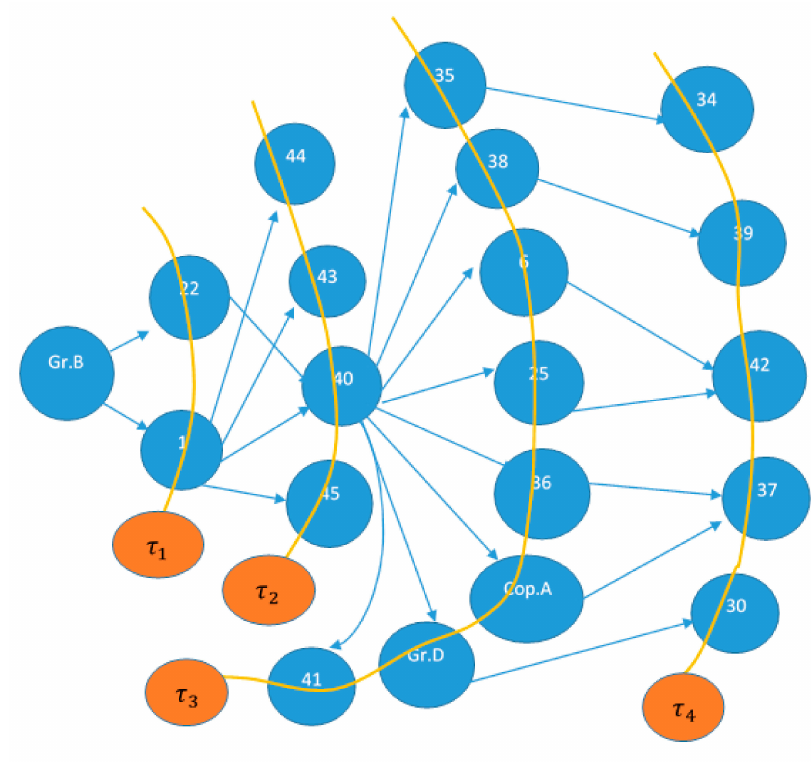
Figure 6. The RG that enables the disassembly of group B.